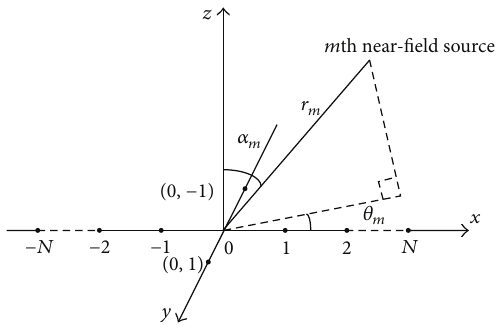
Figure 1: Sensor-source configuration for the near-field